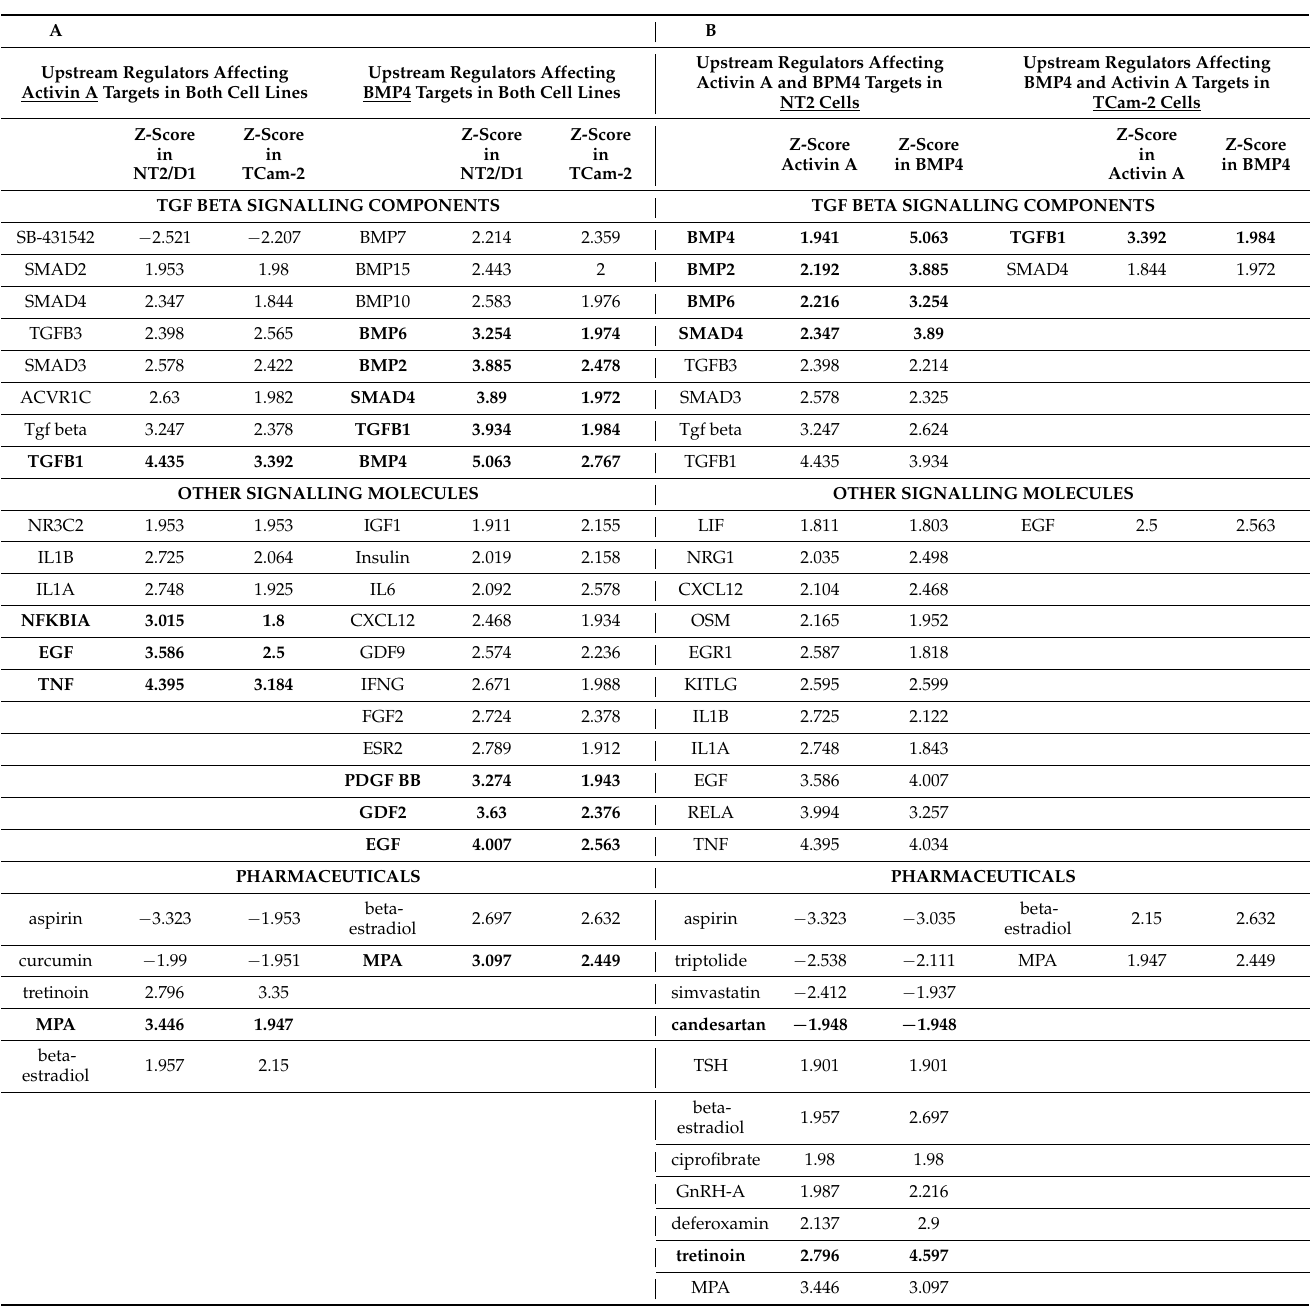
Table 2. Potential upstream regulators of outcomes from activin A and BMP4 signalling identified using Ingenuity Pathway Analysis. The Z score cut off of ± 1.8 was employed, with a Z-score ≤ -1.8 indicating inhibition and a Z-score ≥ 1.8 indicating activation. The predicted upstream regulators were categorized as: TGF-ß signalling components, other signalling components, or